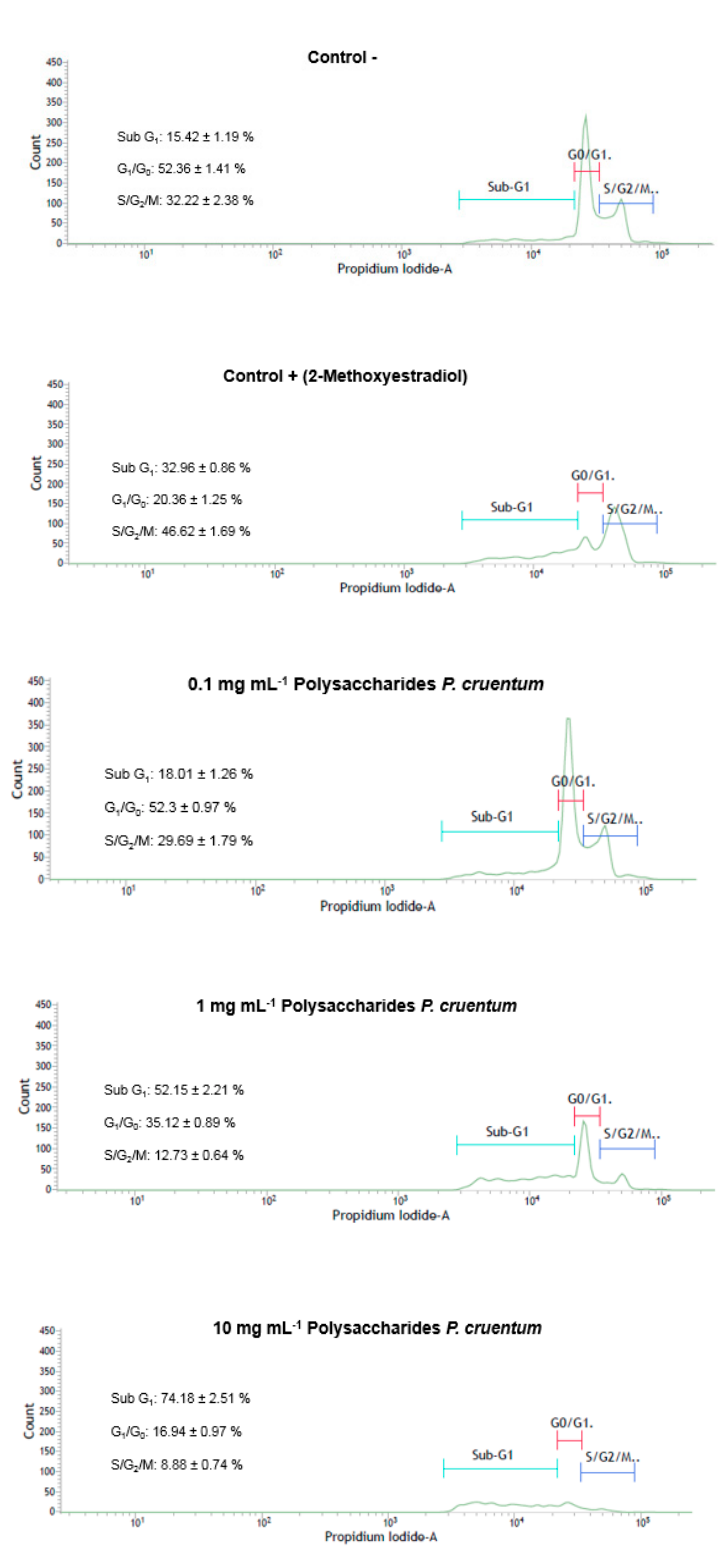
Figure 4. Flow cytometry results for the cell cycle distribution of subpopulations of HL-60 cells in control and samples treated with PcSPs after 24 h. Quantitative analysis of cell cycle data for the full range of tested PcSPs concentration. The plotted values correspond to the mean ± SD from three independent experiments.